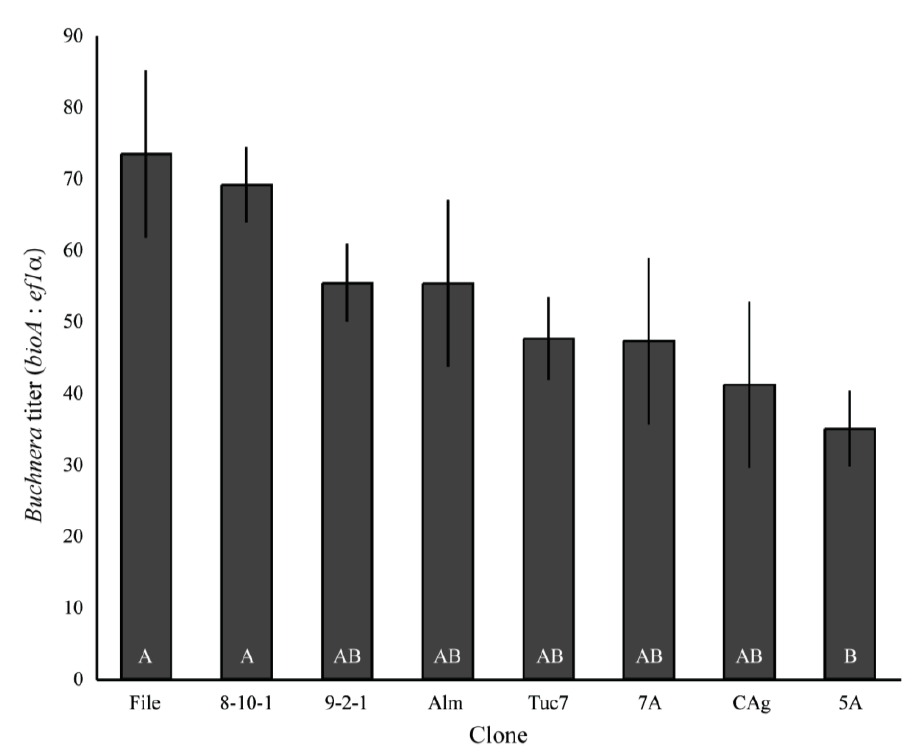
Figure 1. Average Buchnera titer of 1 st instar aphids from lab-reared A. pisum clones. Titer is the ratio of a single-copy Buchnera gene ( bioA ) to a single copy A. pisum gene ( ef1 (cid:4)